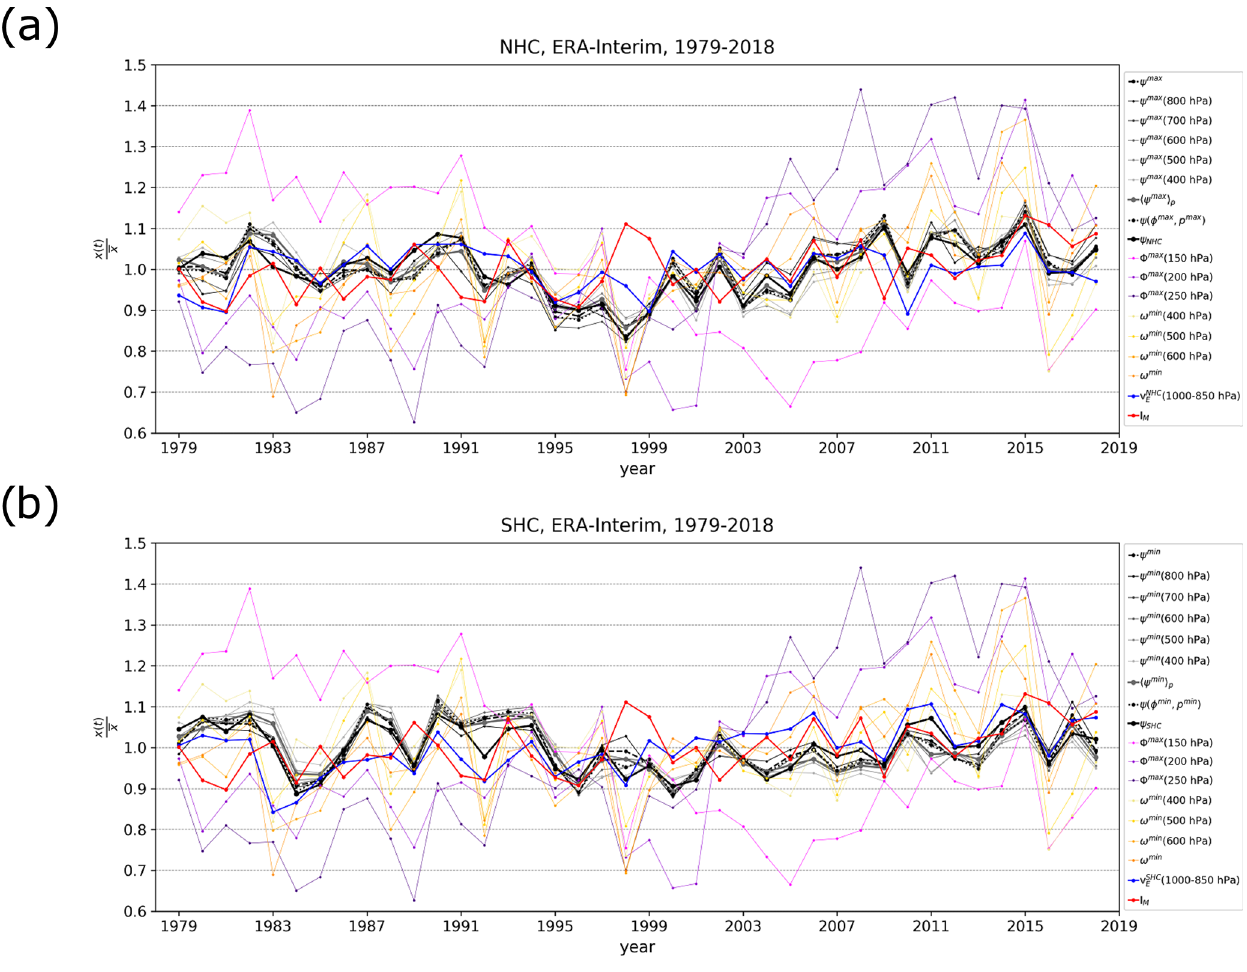
Figure A6. As in Fig. 3, but for the ERA-Interim reanalysis.